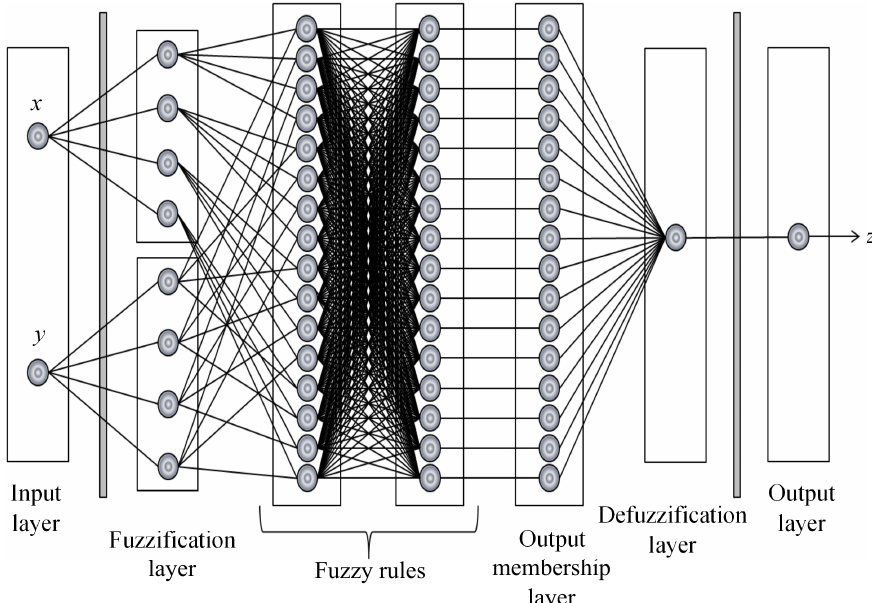
Figure 7. Adaptive neuro-fuzzy inference system (ANFIS) model